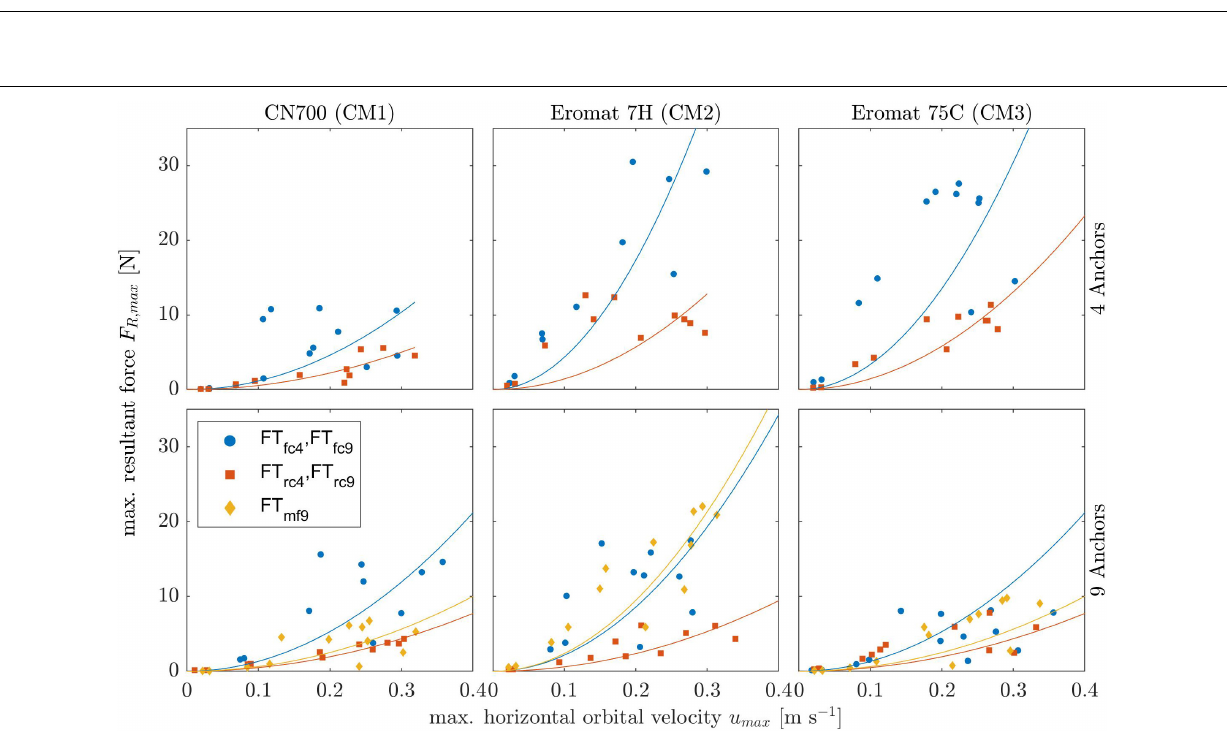
FIGURE 8 | Force-velocity plots of maximum measured horizontal orbital velocities against the respective maximum measured shear and lift forces for all runs. All plots are normalized by the maximum value for the respective set-up. The 2 rightmost panels show the front and rear anchor of the ASG mat (AV). These comprised measurements with repetitions, thus resulting in the shown error bars, while the rest (CM) have no calculated uncertainty. The CM are exclusively for front anchors. Solid lines represent quadratic fits for comparison. Dashed lines in lower plots correspond to middle-front anchor (FT mf 9 , markers omitted for clarity).